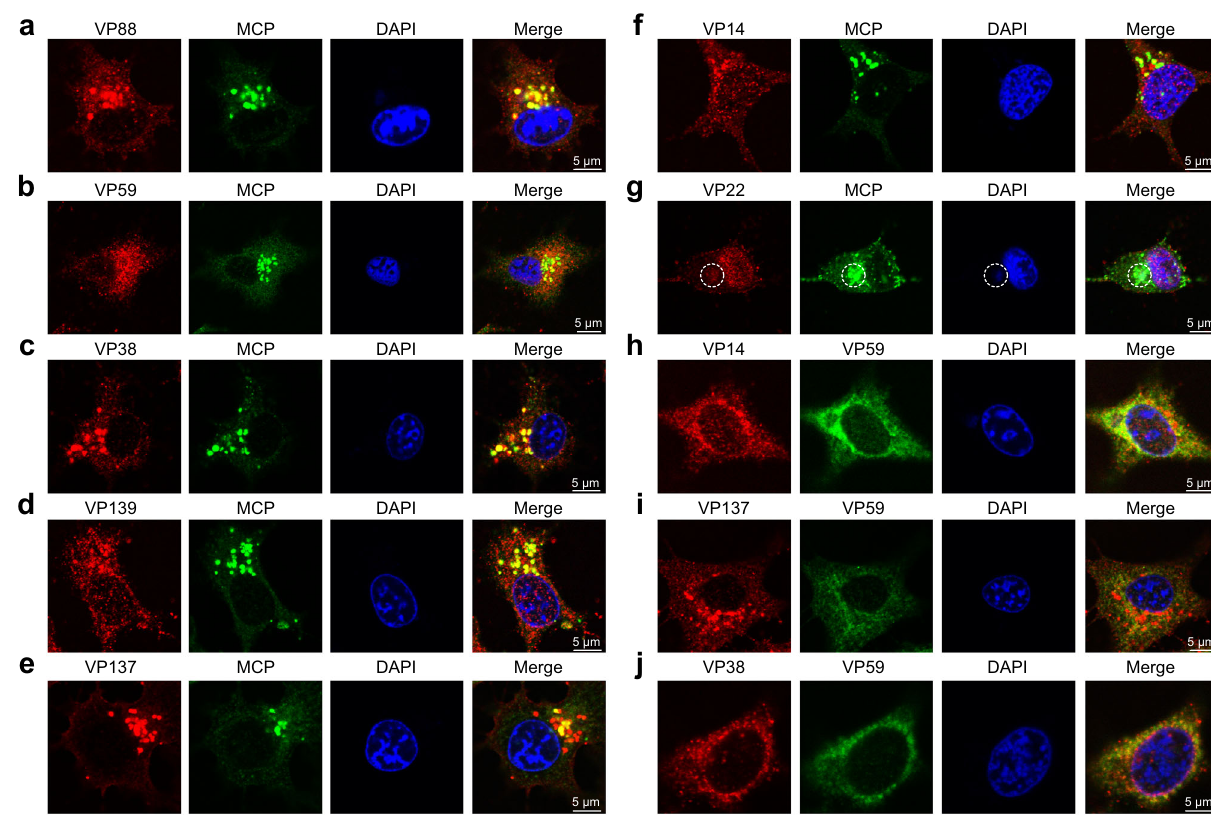
Fig. 6 | Colocalization between mCPs and MCP before the formation of the VF. Immuno fl uorescence colocalization assays between the mCP including VP88 ( a ), VP59 ( b ), VP38 ( c ), VP139 ( d ), VP137 ( e ), VP14 ( f ), or VP22( g ) and the MCP in the SGIV-infectedEAGScellsbeforetheformationoftheVF(12hp.i.).After fi xationand permeabilization, cells were incubated with a mouse mAb against SGIV MCP and rabbit polyclonal antibody against SGIV VP88 (VP59, VP38, VP139, VP137, VP14, or VP22) for 1h. Anti-rabbit Alexa Fluor 555 (red) secondary antibody and anti-mouse Alexa Fluor 488 (green) secondary antibody were used. The area of colocalization